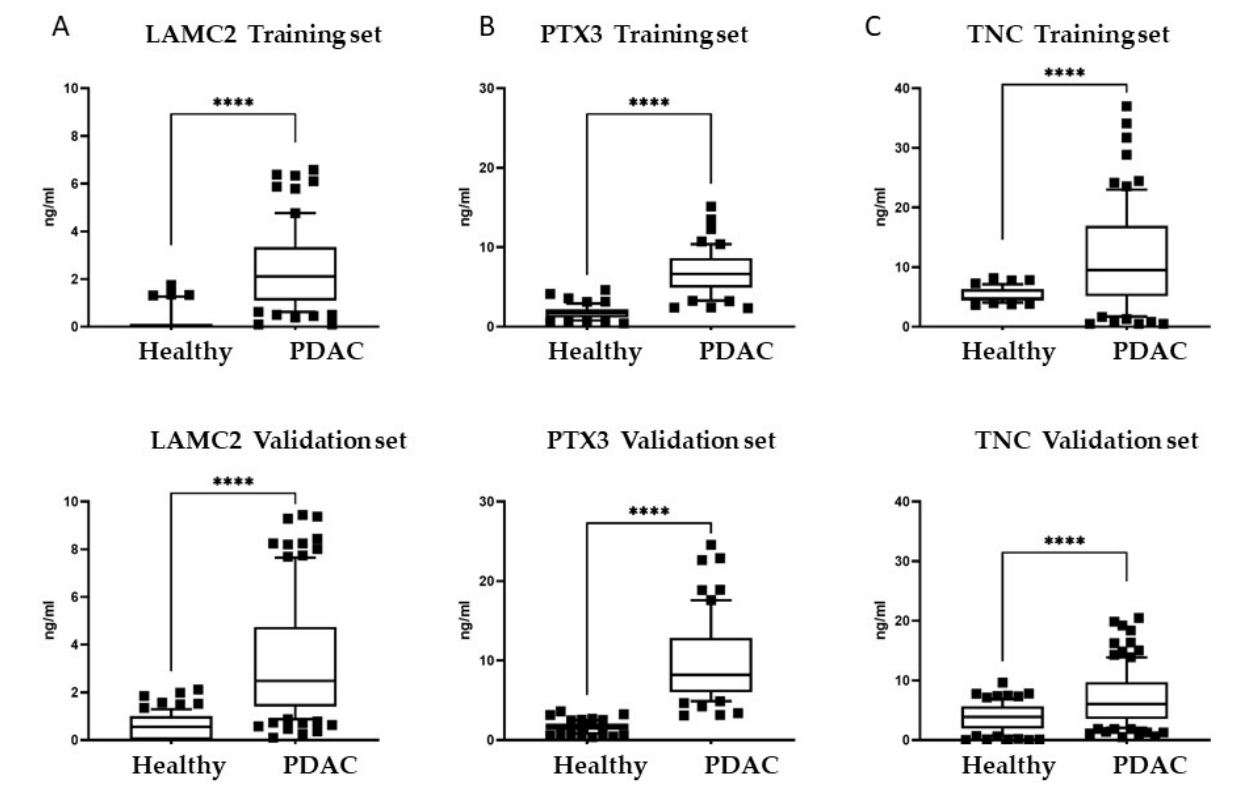
Figure 3. Plasma levels of LAMC2, PTX3 and TNC in pancreatic cancer patients and in healthy donors. Two cohorts were tested, Training set: PDAC n = 78 patients, Healthy n = 53 donors; and Validation set: PDAC n = 122 patients; Healthy n = 82 donors. Plasma concentrations were measured by ELISA: ( A ) LAMC2, ( B ) PTX3 and ( C ) TNC. Statistical analysis: parametric t-test with Welch’s correction, outliers eliminated with «Identifying outliers» ROUT, **** p < 0.0001. Boxes correspond to values comprised between 10 and 90 percentiles.